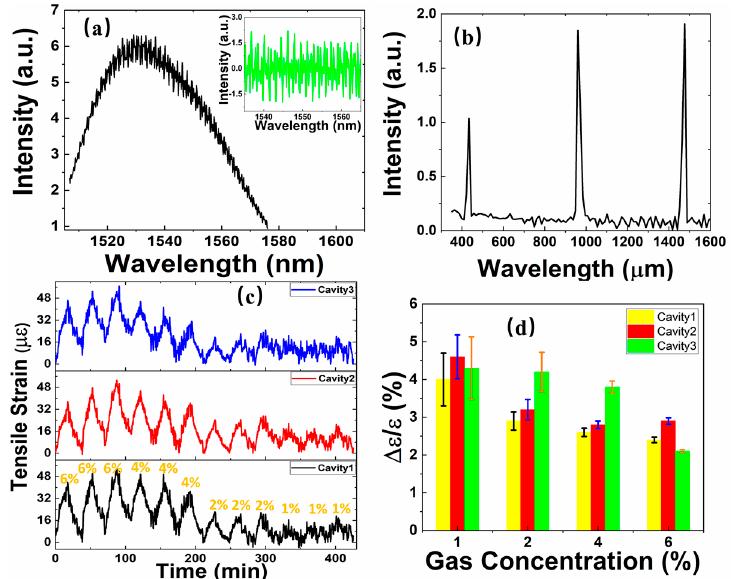
Figure 4. ( a ) Interference spectrum of the IFPI sensor with three sensing cavities. The inset shows an interference spectrum after the light source baseline profile was removed. ( b ) Demodulated cavity length distribution. ( c ) Time-dependent response of IFPI sensors to hydrogen exposure with concentration ranging from 6% to 1%. ( d ) Tensile strain change variations across the multiple gas exposure cycles and sensing cavities. The error bars are calculated according to standard deviation formula [24].